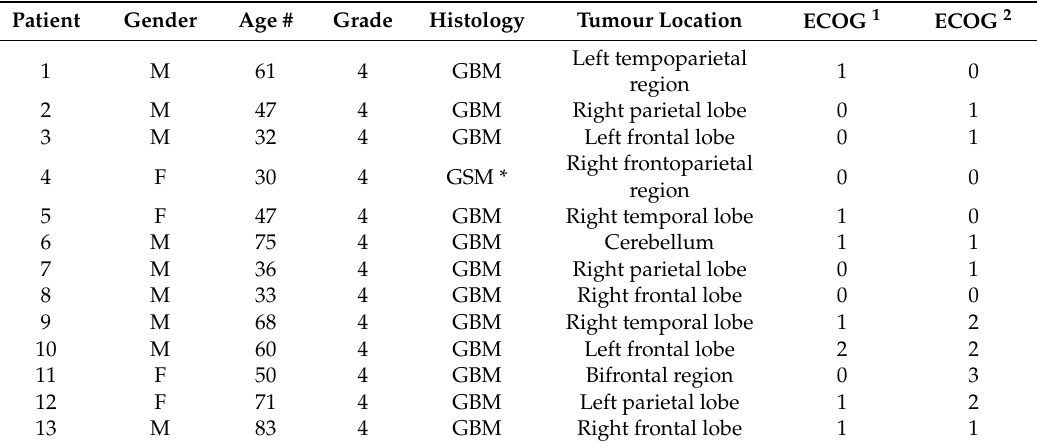
Table 1. Patient